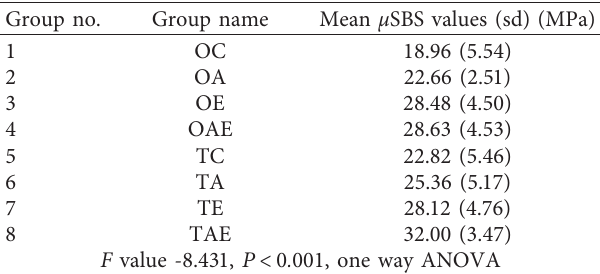
Figure 2: Specimen subjected to Micro-shear Bond Strength ( µ SBS) Test in the Universal Testing Machine. Table 3: Mean micro-shear bond strength ( µ SBS) values in MPa with standard deviation for all the